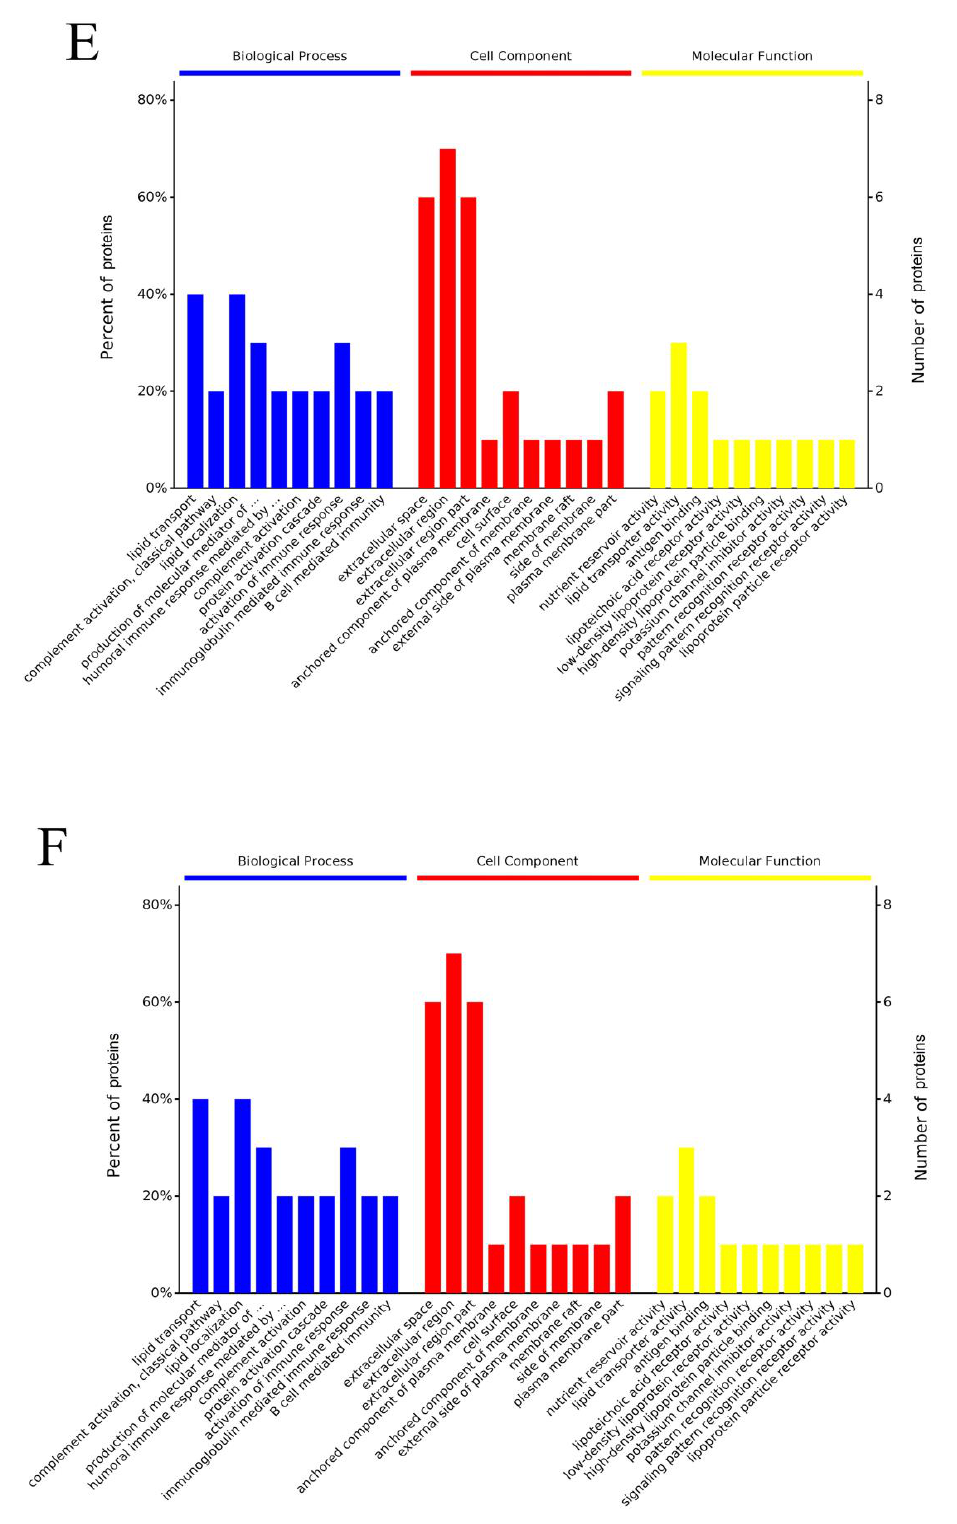
Figure 16. ( A – F ) The GO annotation of differentially expressed proteins after two days ( A , B ), six days ( C , D ), and after 13 days ( E , F ) of embryonic development. The proteins were characterized in three categories: biological process, cel-lular component, and molecular function. The 2, 6, and 13 days of embryonic development was compared with the 0, 2, and 6 days of embryonic development as control,